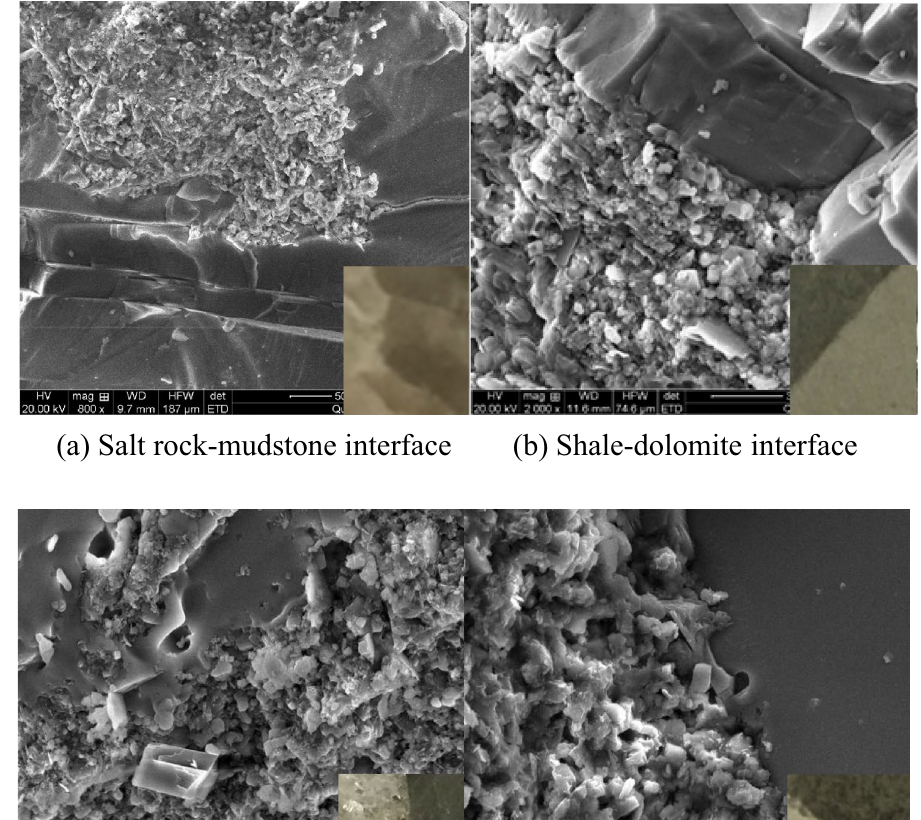
Fig. 6 SEM results of interface between four types of samples